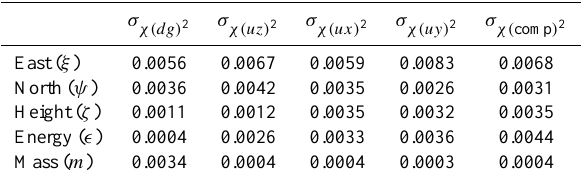
Table 5. Standard deviation of nonnormalized E-FAST first order indices with 30 different seeds.